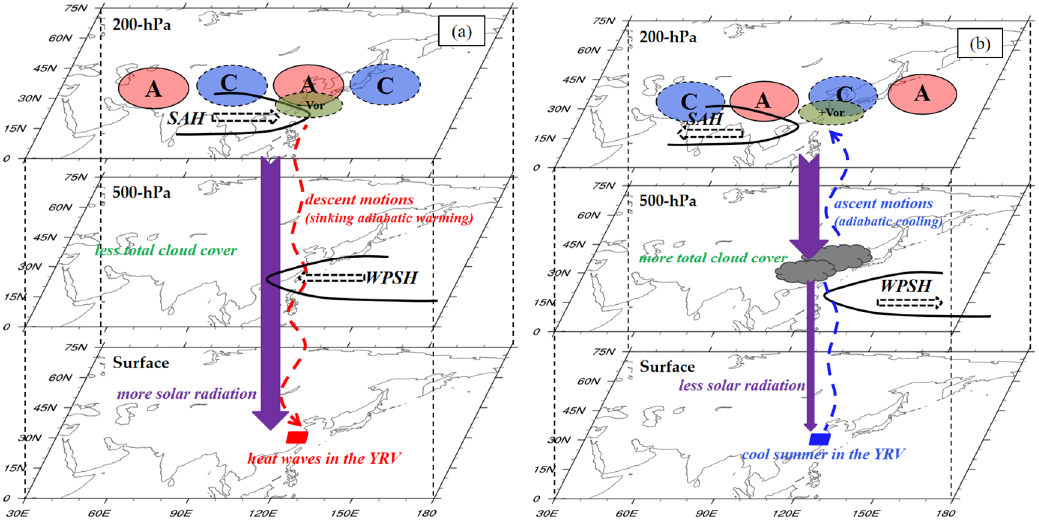
Figure 15. Schematic diagrams for possible causes of the heat waves and cool summer processes in the YRV during the SRP+ ( a ) and SRP− ( b ) events. The letters ‘C’ (blue shadings) and ‘A’ (red shadings) represent the anomalous cyclone and anticyclone, respectively. The black solid lines at 200-hPa and 500-hPa denote the boundary of the SAH and WPSH, whose propagation directions are indicated by the dashed blank arrows. The thick and thin purple arrows denote the more and less solar radiation incident to surface of the YRV, respectively. The more total cover is represented by the gray cloud shape. The ascent and descent motions are presented as blue and red dashed lines. The green shadings denote the positive and negative vorticities over the YRV area.